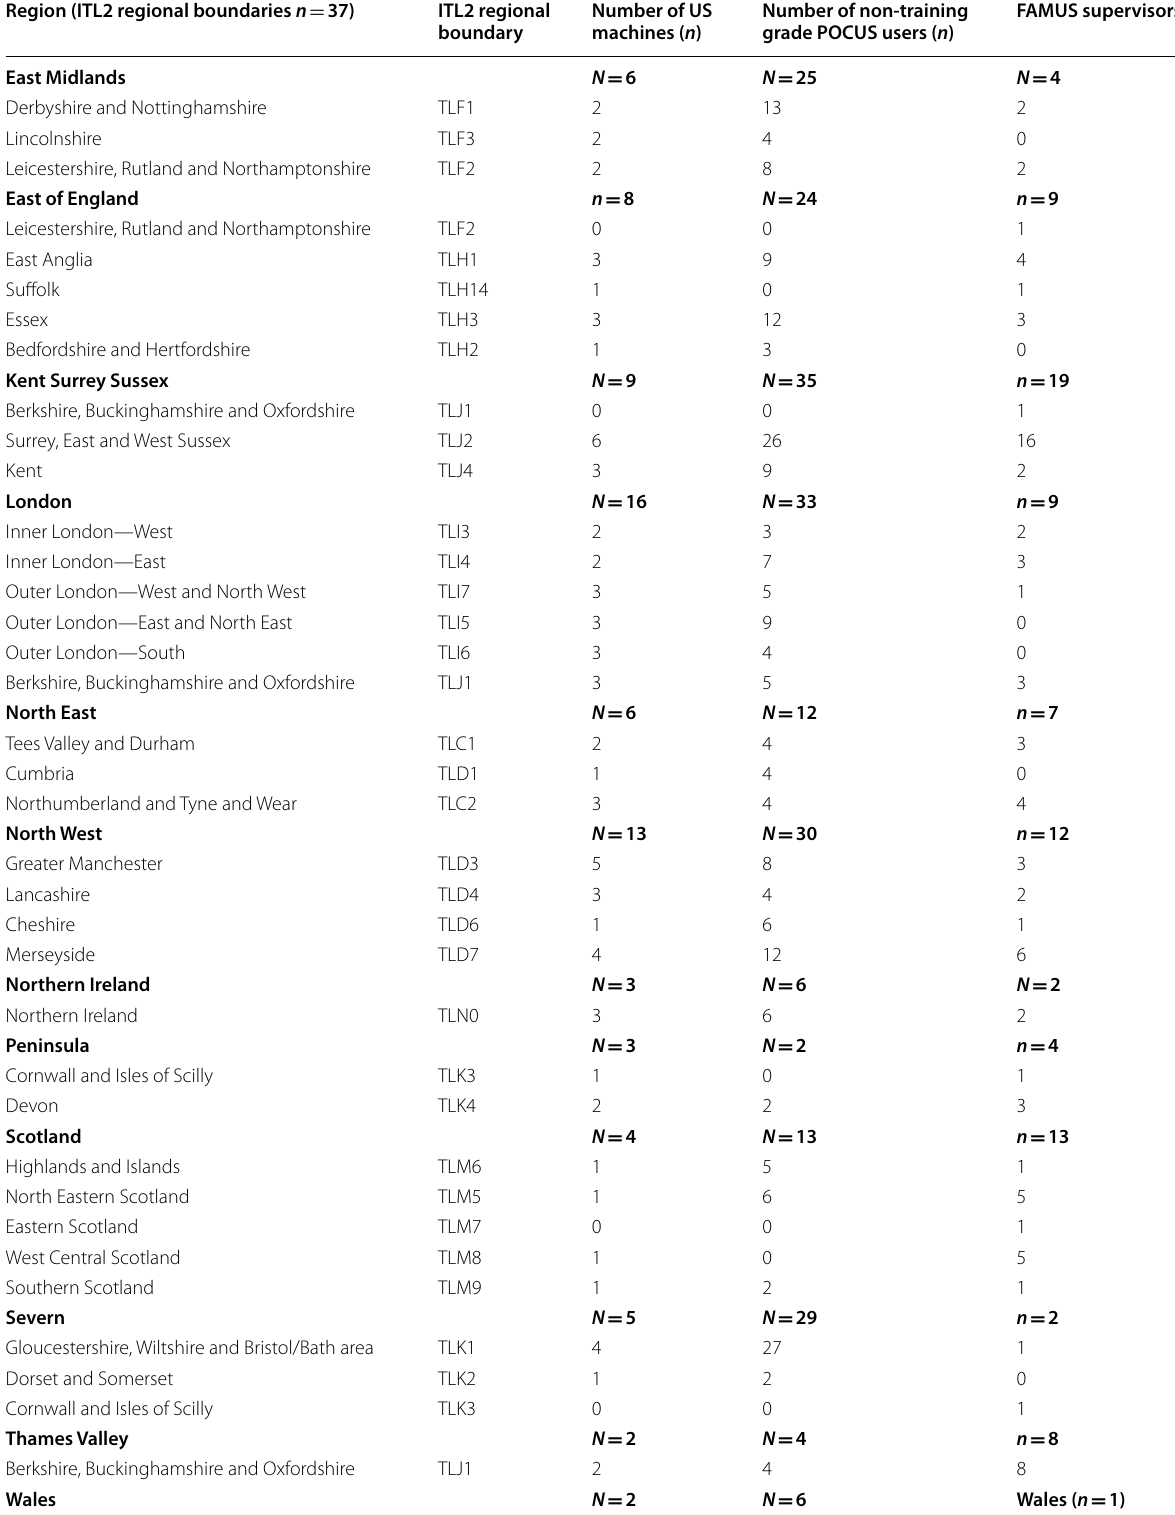
Table 1 Numbers of US machines, non-training grade POCUS users and FAMUS supervisors corresponding to each ITL2 territory (LETB deaneries shown in